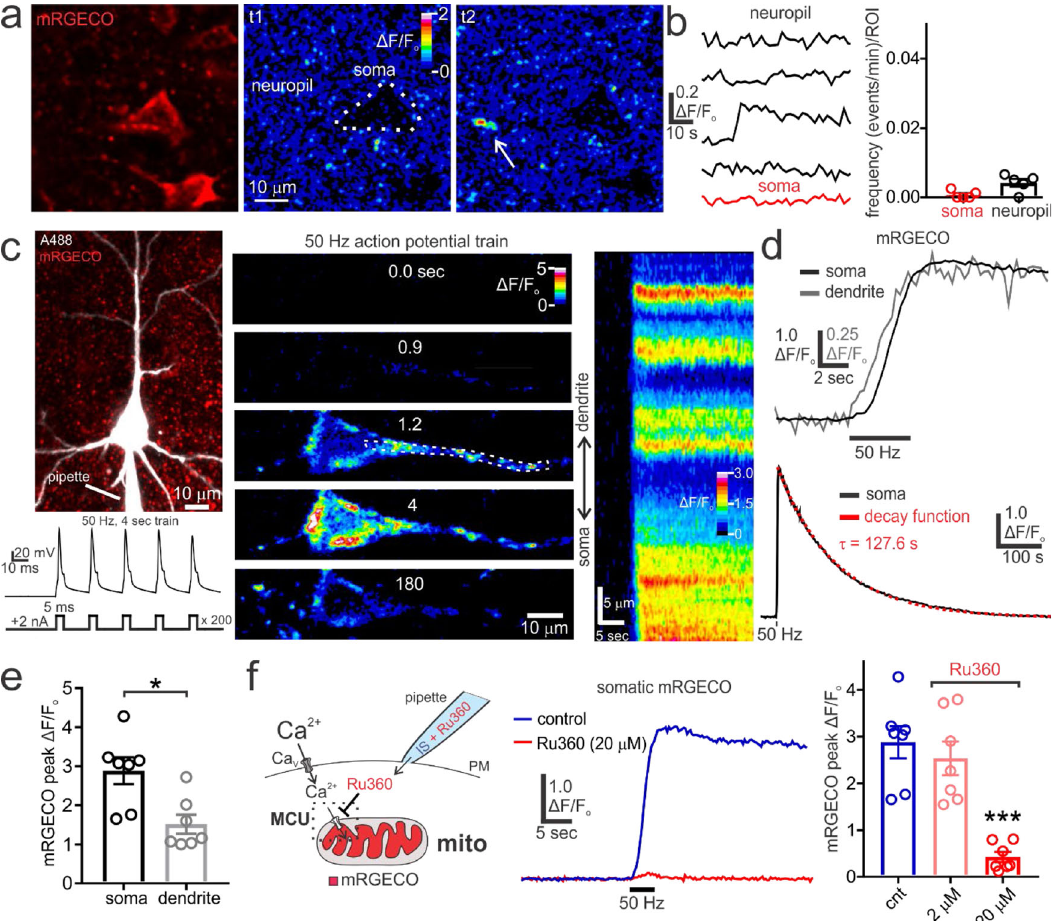
Fig. 1 Pyramidal neuron action potential fi ring triggers a long-lasting mitochondrial Ca 2 + elevation mediated by the MCU. a mRGECO fl uorescence in neurons of the cortex is stable over time ( Δ F/F o ) (time 1 [t1] vs time 2 [t2]), apart from infrequent spontaneous fl uorescence transients seen in the neuropil ( arrow ). b Left , mRGECO fl uorescence from regions of interest (ROI) in the soma and neuropil, showing the stability of the signal and an occasional spontaneous event. Right , Summary data demonstrates the low rate of spontaneous mitochondrial Ca 2 + elevations, which did not signi fi cantly differ between the neuropil and the soma (soma: n = 5, N = 3; neuropil: n = 5, N = 3; Mann-Whitney test, p = 0.063). c Upper Left , Maximum intensity projection of a patch-clamped pyramidal neuron expressing mRGECO and dialyzed with Alexa488 (A488). A 50-Hz train of depolarizing current pulses ( + 2 nA, 5 ms each) elicited under current-clamp recording conditions ( Lower Left ) produced a marked increase in mRGECO fl uorescence ( Δ F/F o ) in the cell body and apical dendrite that lasted for several minutes ( Middle & Right ). Kymograph reveals the spatial pattern of mitochondrial Ca 2 + uptake along the somatodendritic axis after the onset of the action potential train. d Upper , mRGECO fl uorescence measured from ROIs in the soma and apical dendrite shows the onset of mitochondrial Ca 2 + loading shortly after the start of the action potential train. Lower , The somatic mitochondrial Ca 2 + levels slowly recovered to prestimulus baseline in a monoexponential manner (decay time constant [ τ ]). e Summary data showing a signi fi cantly larger evoked mRGECO fl uorescence change in the soma relative to the apical dendrite (soma: n = 7, N = 4; dendrite: n = 7, N = 4; paired t test, p = 0.031). f Left , Illustration depicting the method for blocking the MCU by intracellular dialysis of Ru360 via the internal solution (IS) of the patch pipette. Middle & Right , Action potential evoked mitochondrial Ca 2 + uptake is signi fi cantly reduced by 20 µ M Ru360, but not 2 µ M Ru360, relative to control (control: n = 7, N = 4; 2 µ M Ru360: n = 7, N = 2; 20 µ M Ru360: n = 7, N = 3; One-way ANOVA with Dunnett ’ s multiple comparisons test: 2 µ M Ru360, p = 0.62; 20 µ M Ru360, p < 0.0001). The Control data set is reproduced from the summary data in panel E. Summary data presented as the mean ± SEM. * P < 0.05, *** P < 0.001. The number of cell replicates is shown in the graphs as well as the ‘ n ’ value in the text. The number of animal replicates is represented by the ‘ N ’ value. Source data used for all summary fi gures are provided in the Supplementary Data 1 fi